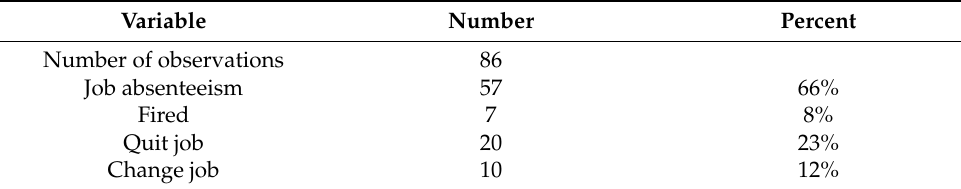
Figure 2. Primary caregivers’ activities related to the patients’ treatment. Table 5. Impact on the primary caregivers’ labor market